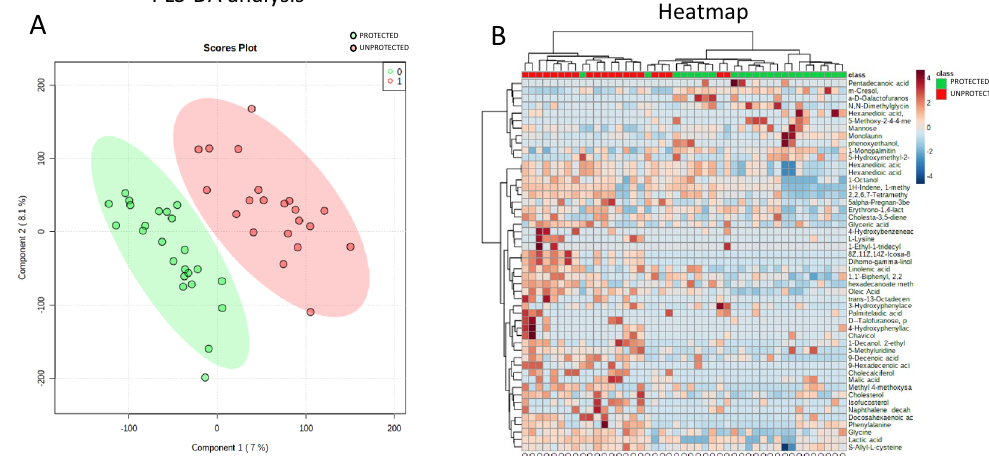
Figure 2. Quantified small molecules in serum from healthcare workers. Partial least square analysis (PLS-DA) performed on all the samples showed two well-defined clusters of subjects (protected = green; unprotected = red) based on the metabolomics profile ( A ). Hierarchical heat maps of quantified small molecules highlighting the two groups of samples, with subjects that contracted COVID-19 in red and subjects that were protected from SARS-CoV-2 in green ( B